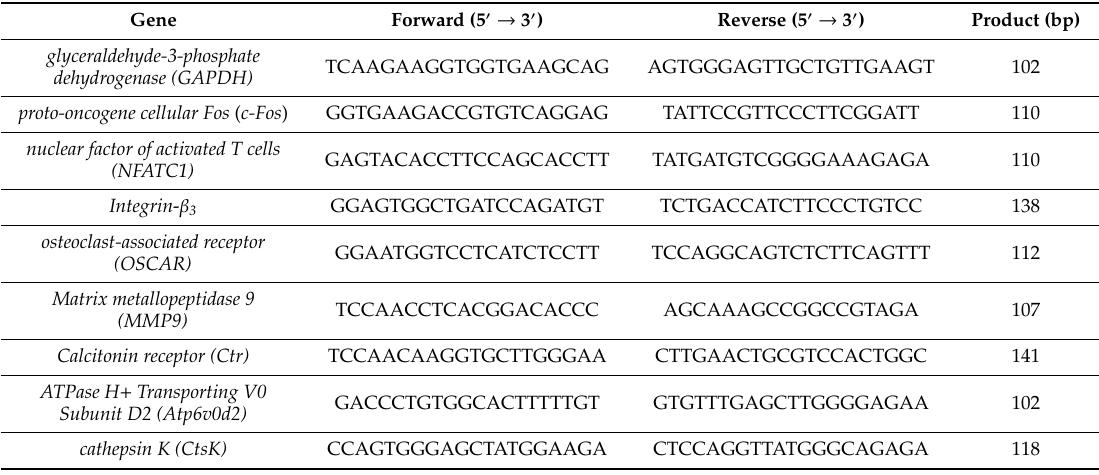
Table 1. Primer sequences used for real-time PCR